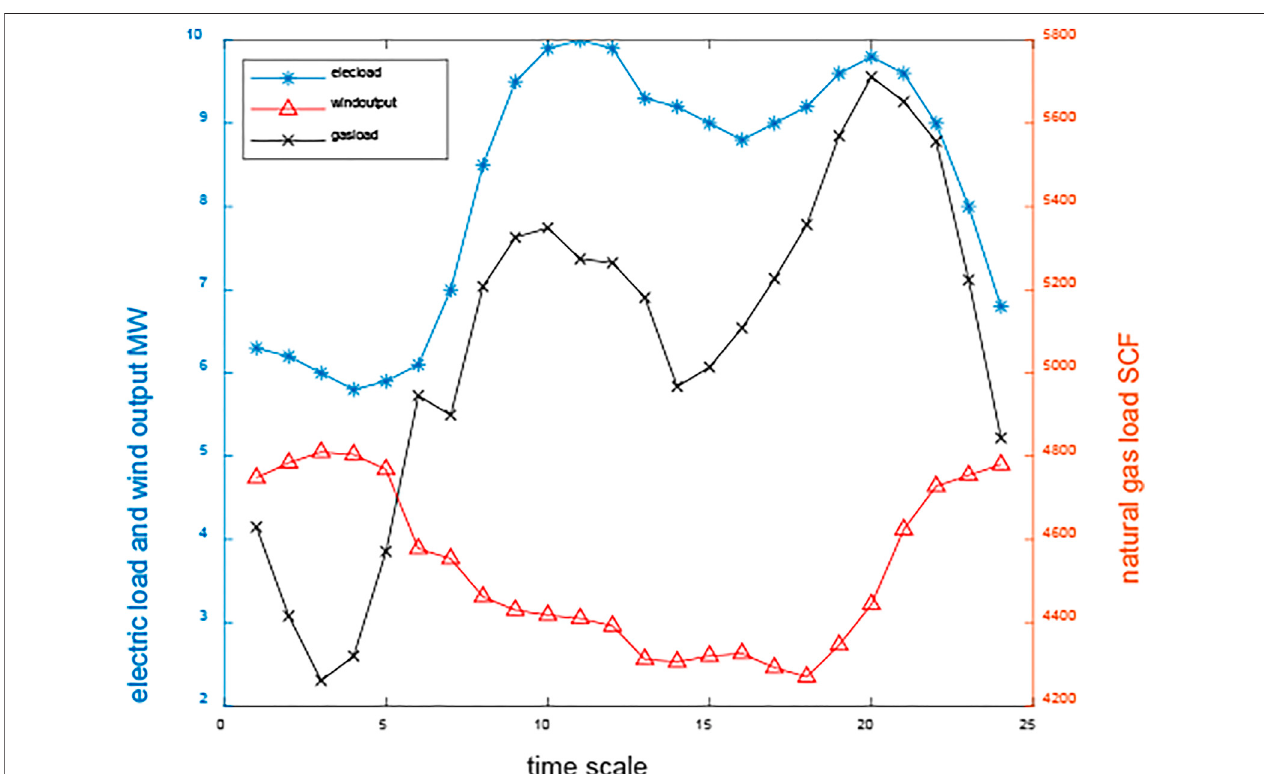
FIGURE 8 | Predicted values of electrical load, wind output, and the gas